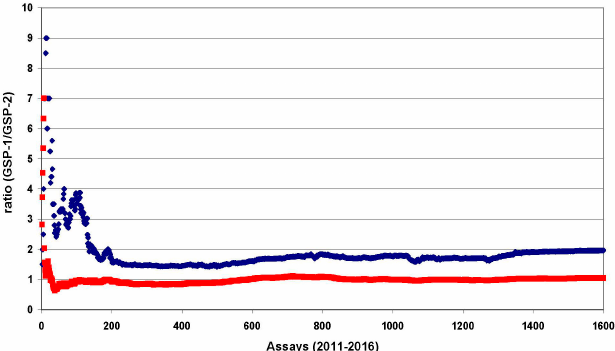
Figure 1. Utilization ratio of both Genetic Screening Processors (GSPs) over 5 years; ( (cid:4) ) = ratio of total number of measurements; ( (cid:7) ) ratio of “floating disc”